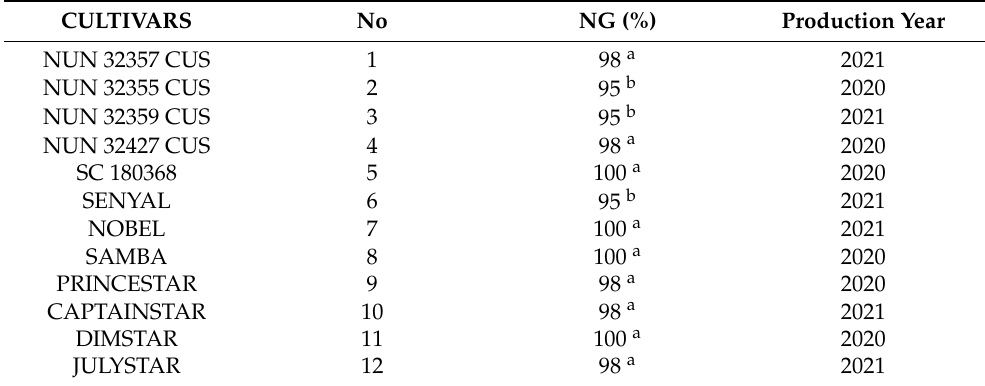
Table 1. Normal germination percentages and production year of hybrid cucumber seed cultivars. NG means with different letters are significant at the 5%